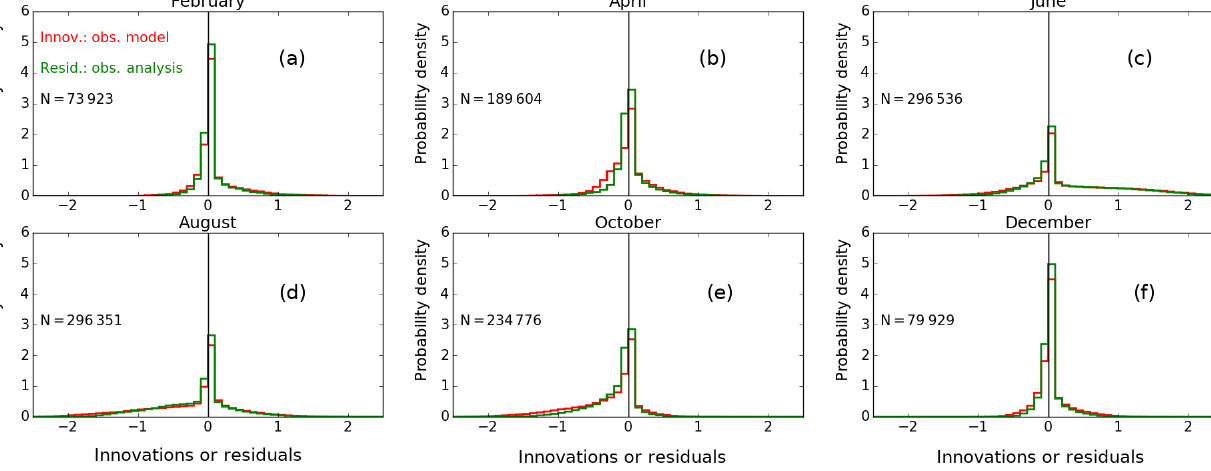
Figure 8. Probability density function of innovation (observations–open loop in red) and residuals (observations–analysis, in green) for leaf area index for (a) February, (b) April, (c) June, (d) August, (e) October and (f) December over 2000–2012. Sampling ( N ) is reported on each